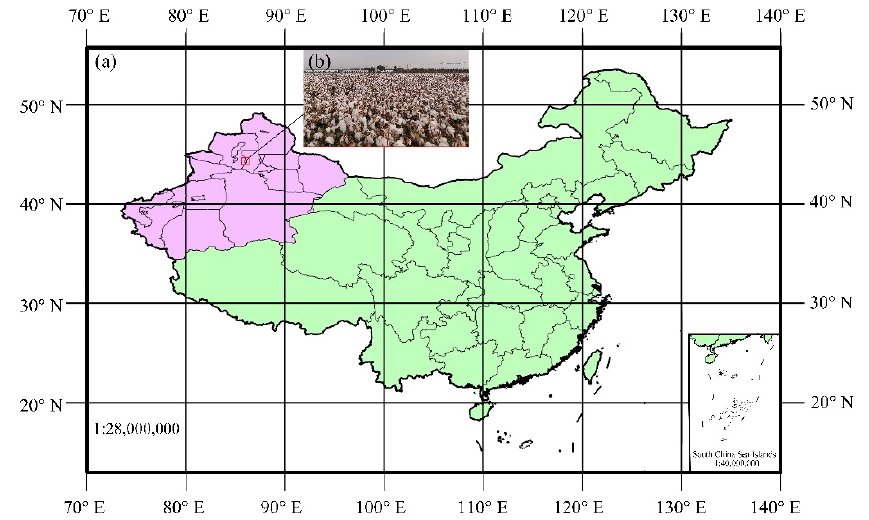
Figure 1. The situation of the experiment filed. ( a ) the specific geographical location of the experi- mental field, in which is 88.99° E, 44.31° N; ( b ) Experimental cotton field.